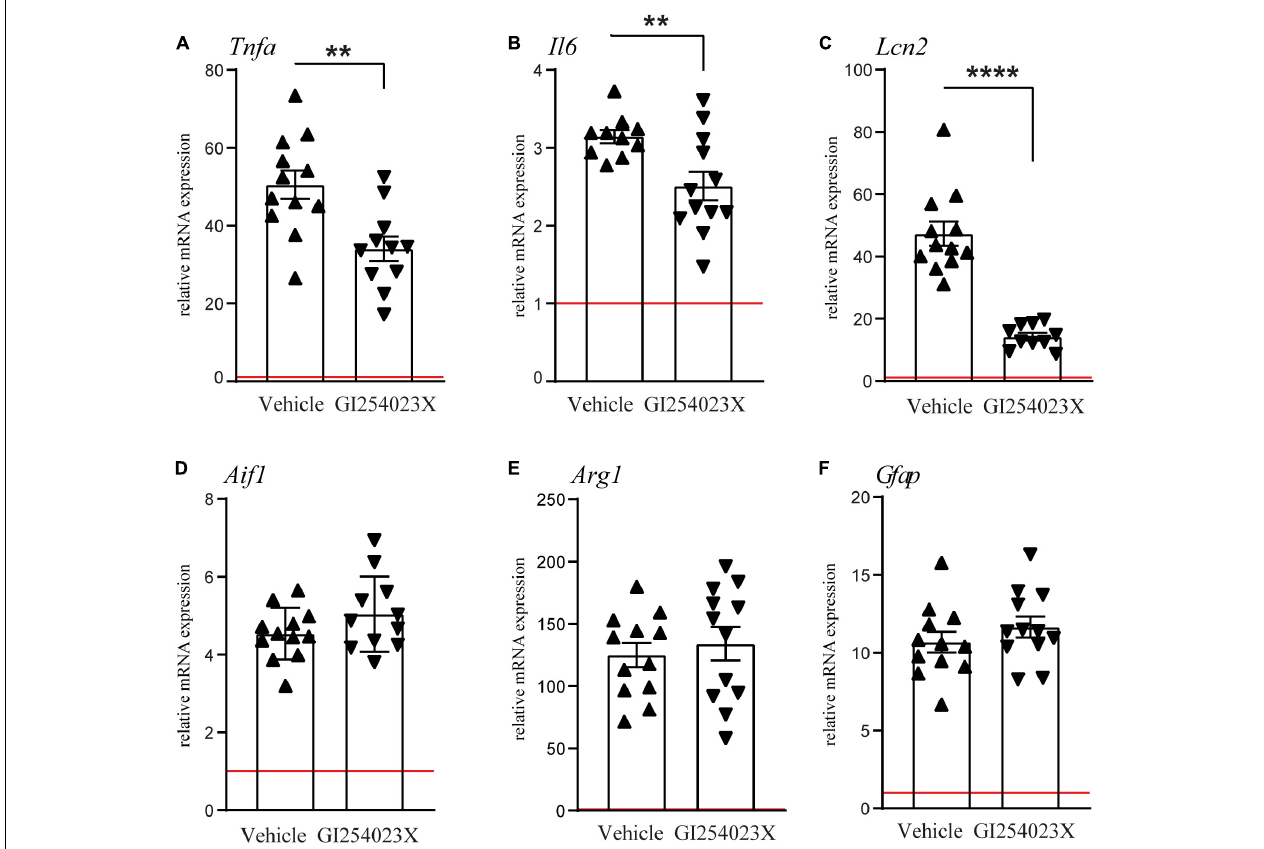
FIGURE 4 | GI254023X attenuates pro-inflammatory gene expression after TBI. (A–F) Histograms showing relative mRNA expression of TNFa ( Tnfa ), IL-6 ( Il6 ), LCN2 ( Lcn2 ), Iba1 ( Aif1 ), Arginase1 ( Arg1 ), and GFAP ( Gfap ) at 7 dpi in ipsilesional brain tissue samples. Expression values were normalized to the reference gene Ppia and data are shown relative to sham (red line = sham). Outliers were removed from GI254023X- or vehicle-treated CCI groups after identification by ROUT’s test. Values from individual animals and mean ± SEM are shown. P -values were calculated by Student’s t -test (A–C) (** p < 0.01, **** p < 0.0001).